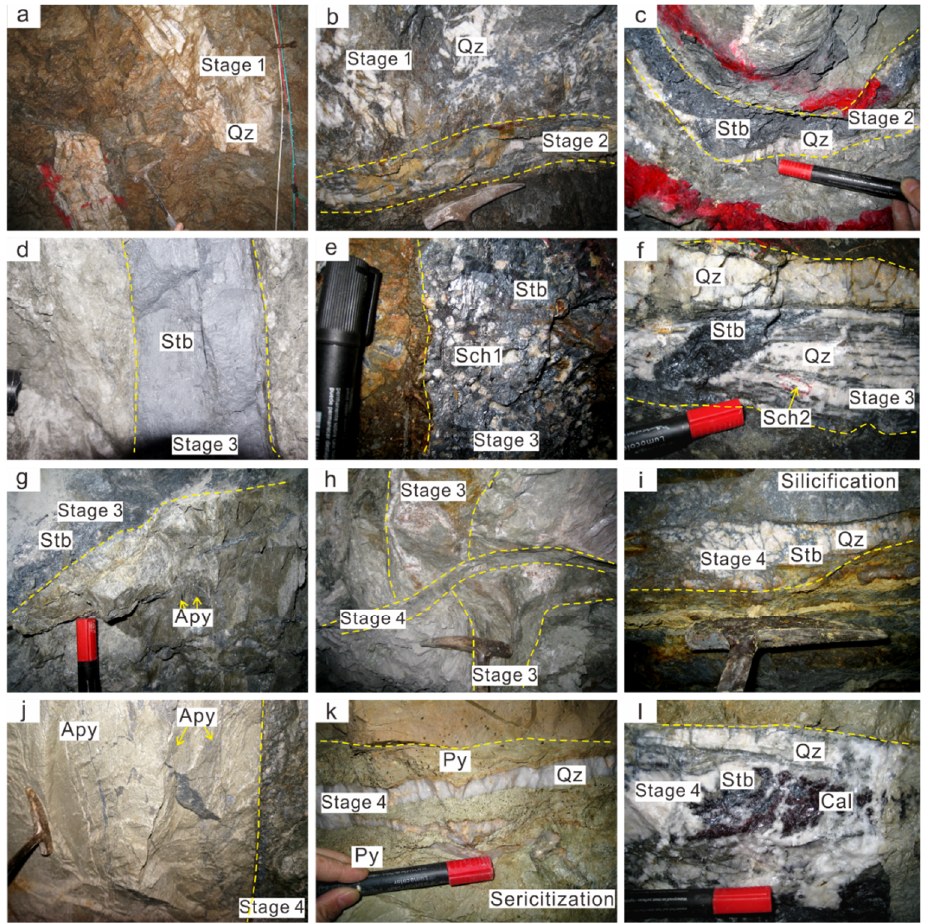
Figure 4. Field occurrences of mineralization and alteration in the Longshan Sb-Au deposit. ( a ) Deformed Stage-1 quartz veins occur as irregular veins within Jiangkou Formation; ( b ) Stage-2 quartz-sulfide veins cut the Stage-1 quartz veins, with distinct boundaries; ( c ) Quartz and stibnite from the Stage-2 show intense deformation; ( d ) View of the Stage-3 fine-grained stibnite vein within Jiangkou Formation; ( e ) Stage-3 fine-grained Sch1 scheelite cemented by stibnite; ( f ) Stage-3 quartz-stibnite mineralization associated with Sch2 scheelite; ( g ) Fine-grained arsenopyrite and quartz-stibnite veinlets developed proximal to the Stage-3 stibnite vein; ( h ) Crosscutting relationship between Stage-3 and Stage-4 quartz veins; ( i ) Stage-4 intense host rock silicification through a network of veins defining a brecciated host-rock and the intergrowth of quartz and stibnite; ( j ) Fine-grained, sparsely disseminated arsenopyrite developed proximally to the Stage-4 ore veins in the country rocks; ( k ) Coarse-grained, densely disseminated pyrite developed intensively in the wallrock close to the Stage-4 quartz vein, note the abundance of sericitization within the discolored wallrock; ( l ) Stage-4 assemblage of stibnite and calcite in the quartz vein. Qz = quartz; Stb = stibnite; Sch = scheelite; Apy = arsenopyrite; Py = pyrite; Cal = calcite.